Question: What visual encoding does this figure use to show its data?
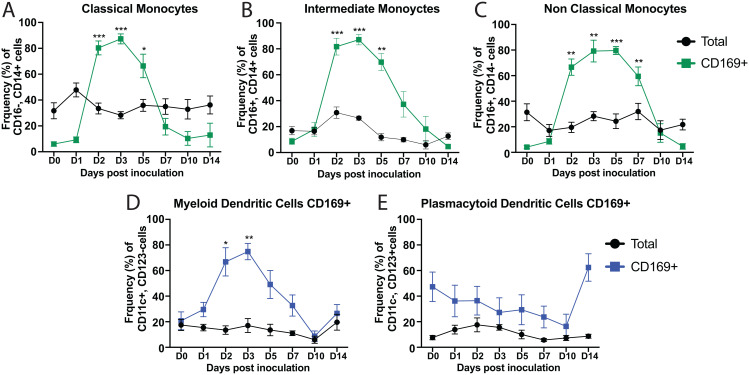
Answer: bar